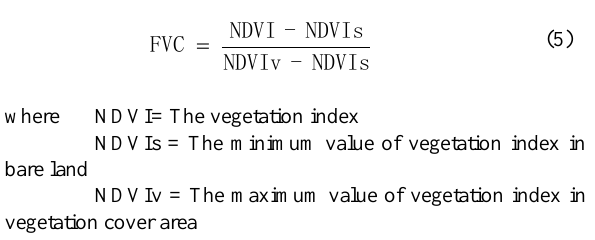
where NDVI= The vegetation index NDVIs = The minimum value of vegetation index in bare land NDVIv = The maximum value of vegetation index in vegetation cover area The dimidiate pixel model assumes that pixels are composed by vegetation ones and non-vegetation ones (Li M M, 2004a). In general, NDVI values of vegetation and non-vegetation take the maximum and minimum within the confidence interval to eliminate the noise caused by remote sensing images 2 . In this paper, the maximum value is 95% and the minimum value is